Question: According to this chart, does the measure grow or shrink?
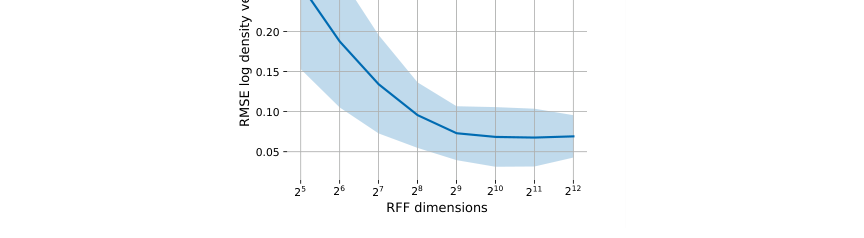
Answer: increasing